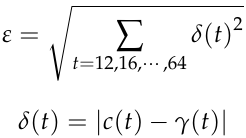
Figure 4. Curve fitting results using the three models for C40 under standard curing. Table 1. The total fitting errors of the three prediction models.